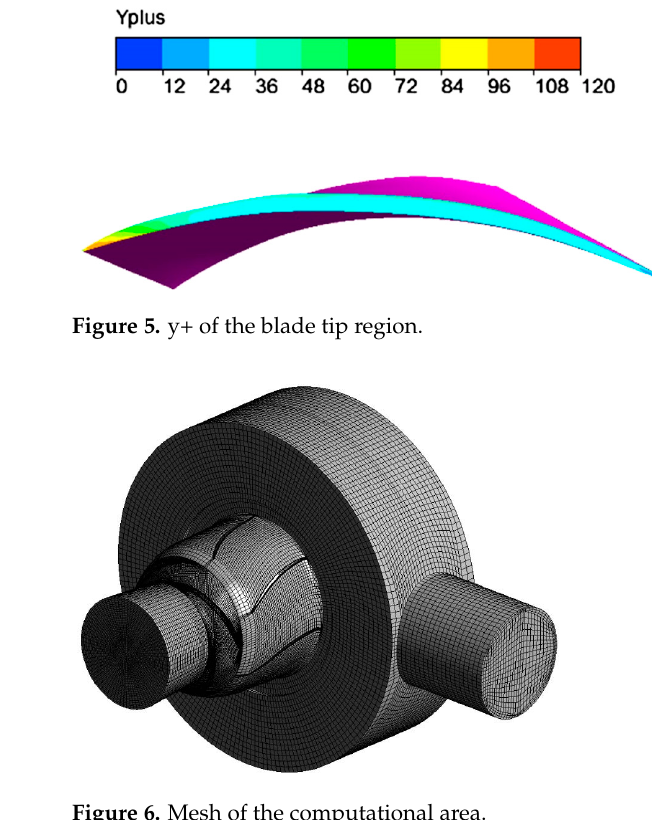
Figure 6. Mesh of the computational area. Table 1. Boundary conditions.